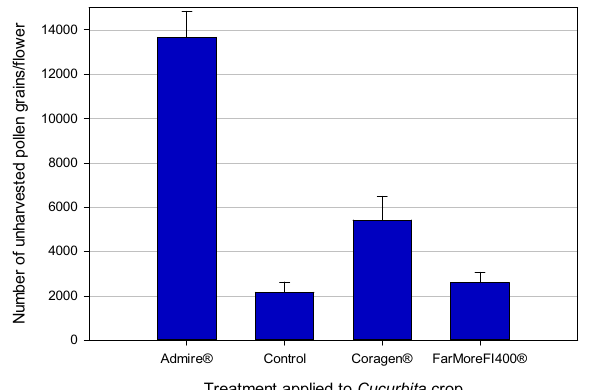
Figure 2. Number of pollen grains remaining unharvested on each staminate squash flower ( Cucurbita pepo , var. Table Star) anther at the end of the squash bee ( Eucera ( Peponapis ) pruinosa ) daily foraging period (dawn to 11 am). Bees were kept in hoop houses in which one systemic insecticide treatment (either Admire- imidacloprid, applied to soil at seeding; or Coragen-chlorantraniliprole applied as a foliar spray; or FarMore FI400-thiamethoxam applied as a seed treatment) was applied to the crop 8-weeks before the bee active period, or the crop remained untreated as a control. Data presented are means ± SE across three hoop houses per treatment from